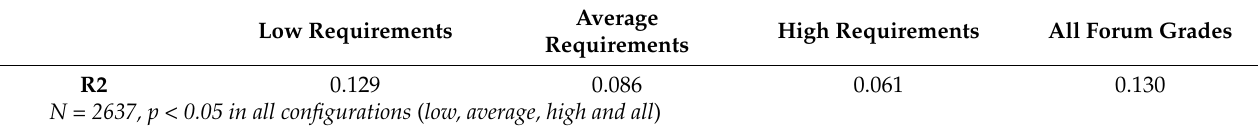
Table 8. Percentage of the variability of grades from summative assessment activities explained by forum grades.